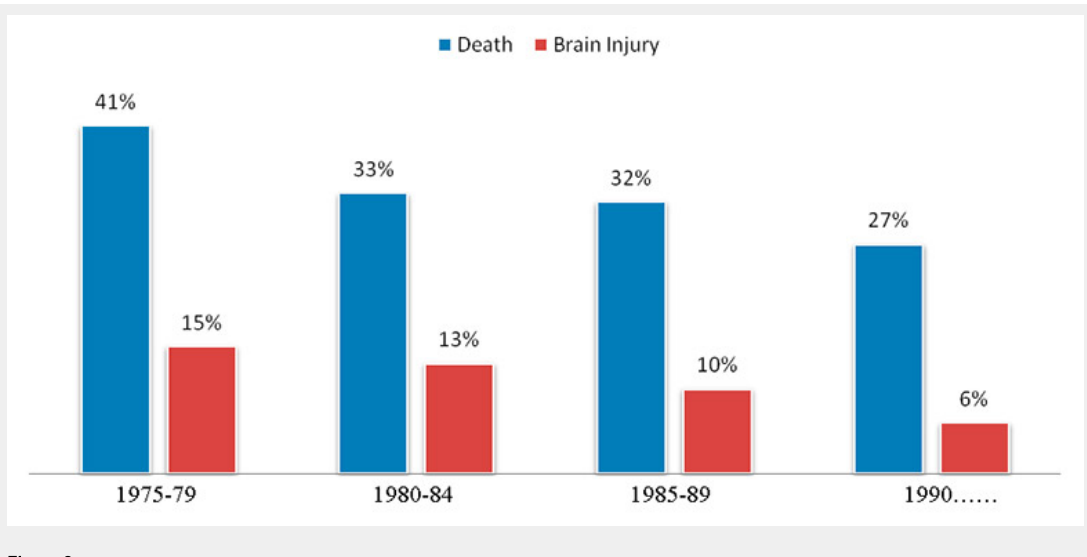
Figure 2 Claims for death and brain injuries as a proportion of all claims